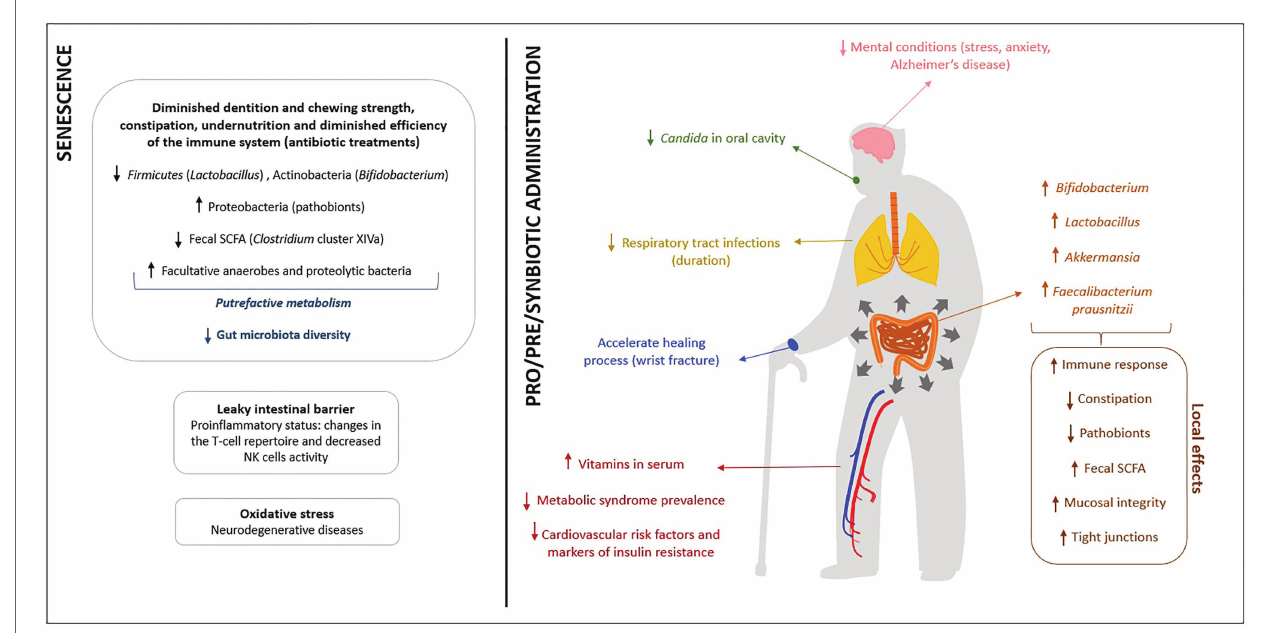
FIGURE 1 | Summary of the main health effects attributed to probiotics,prebiotics and synbiotics in the